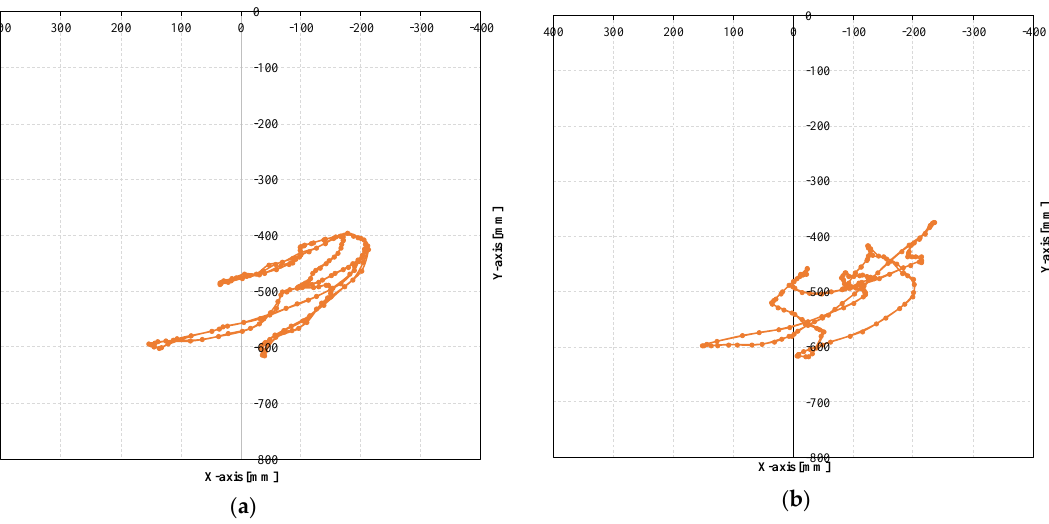
Figure 16. Trajectory of the leg tip using evaluation function 1 with 0.5 kg (( a ) first generation, ( b ) 18th generation).